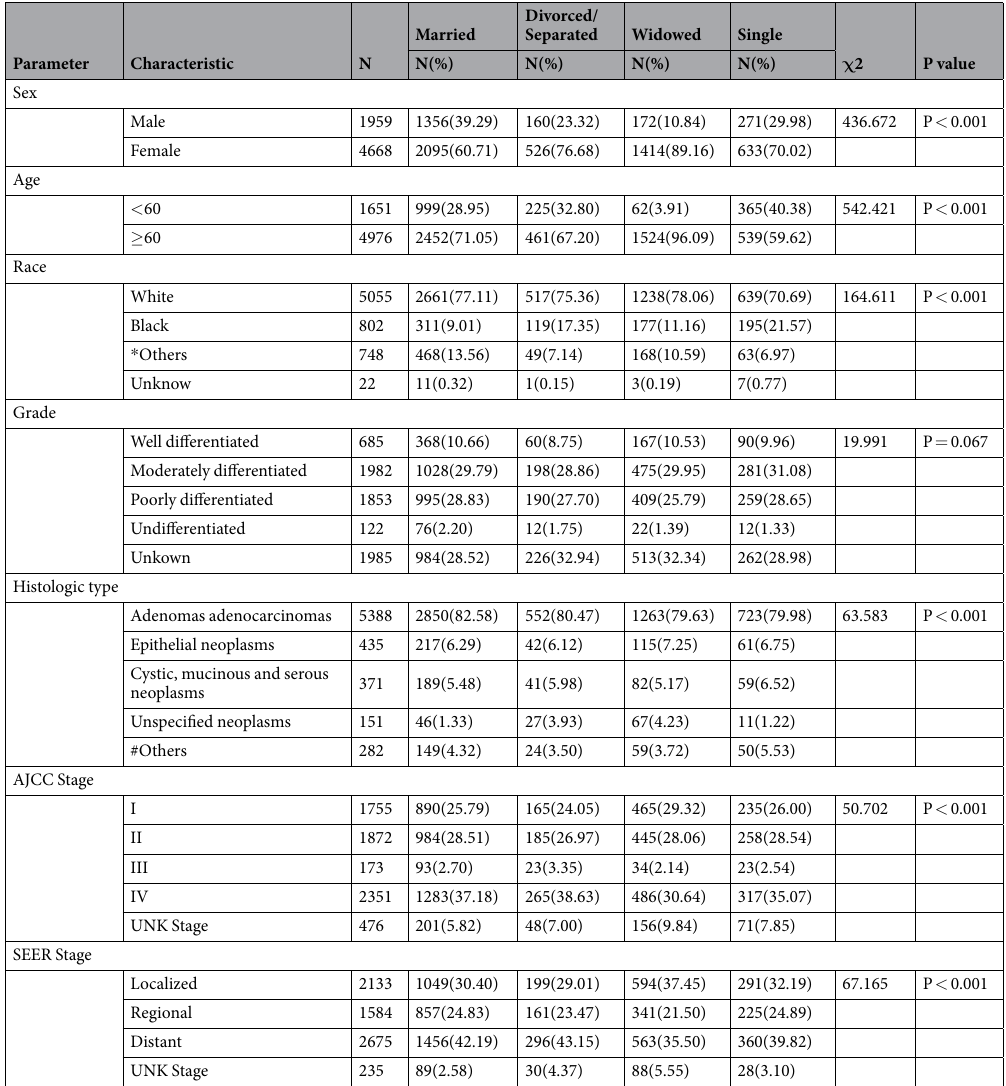
Table 1. Characteristics of patients with GBC in SEER database. * Other includes American Indian/AK Native, Asian/Pacific Islander. # Other includes squamous cell carcinoma/complex epithelial neoplasms/complex mixed and stromal neoplasms. /ductal and lobular